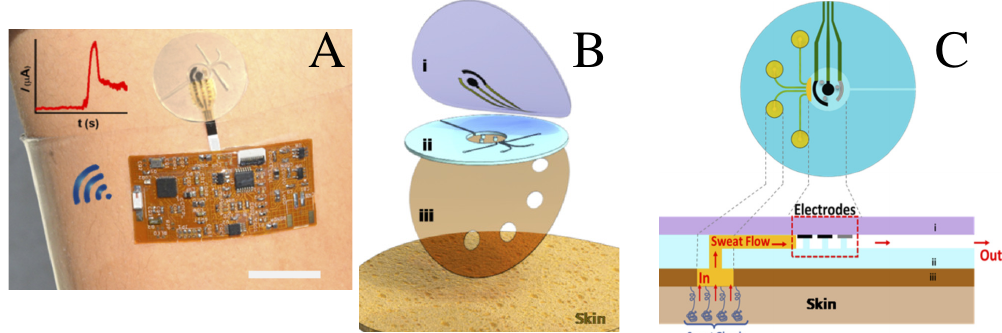
Figure 7. ( A ) Photograph of a wearable microfluidic device integrated with electronics for wireless communication. ( B ) Pictorial representation of microfluidic device composed of: (i) top PDMS layer with probing electrodes; (ii) PDMS microfluidic device; and (iii) adhesive layer on the skin. ( C ) Schematic representation of sweat collection and electrode operation on skin. Reproduced with permission from Ref. [88]. Copyright 2017 American Chemical